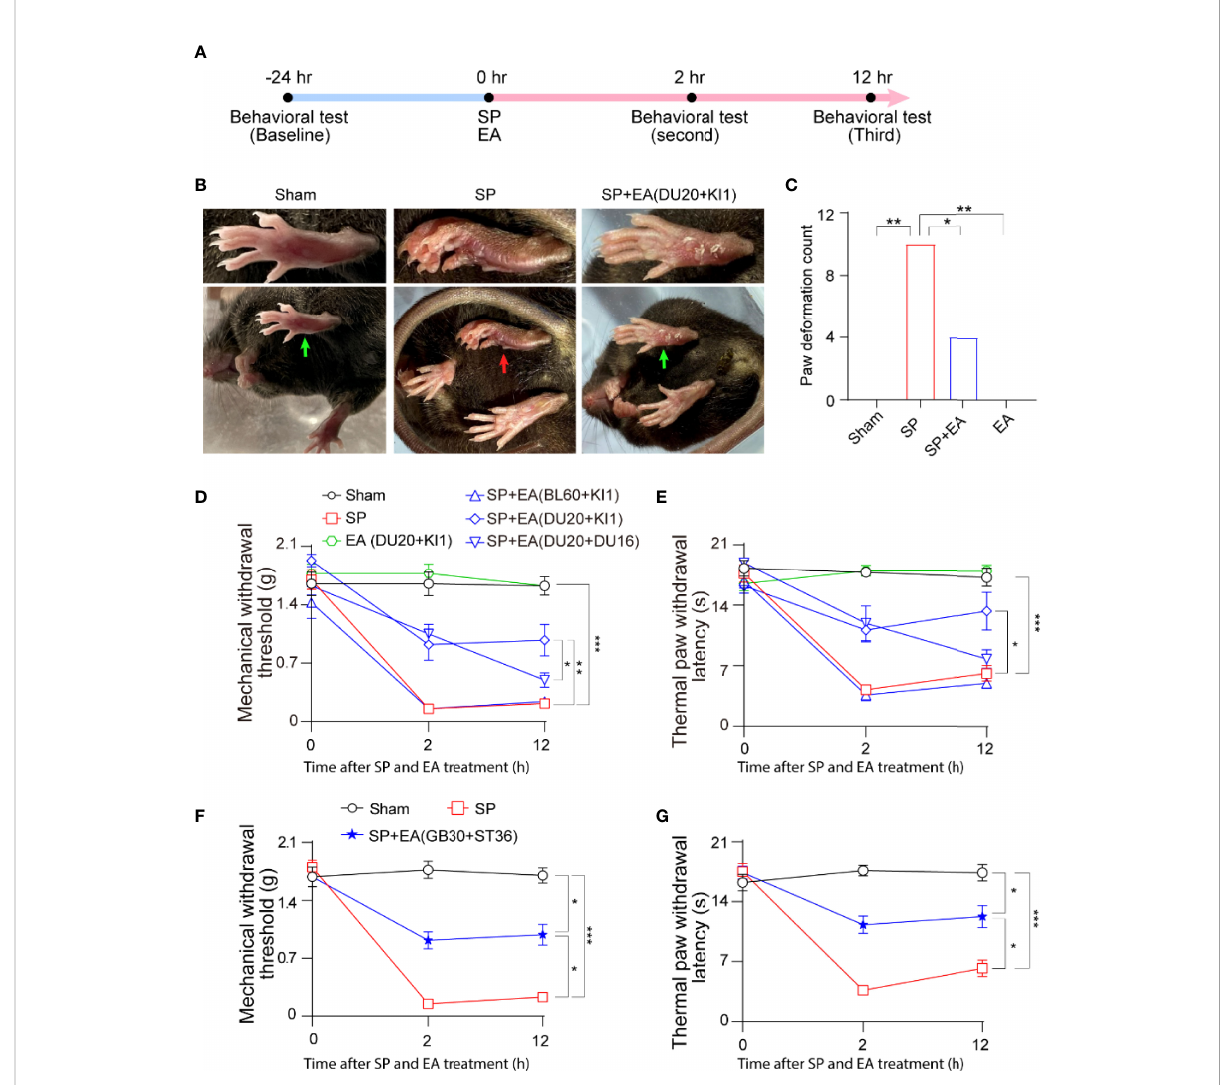
FIGURE 1 EA attenuates surgical pain (SP) in mice. (A) Diagram of procedures and behavioral tests. (B) Representative photos of paw deformation induced by SP in the foot. The red arrow indicates paw deformation in surgery mice; green arrows indicate normal paw in sham and SP plus EA mice. (C) Paw deformation counted at 12 h after the surgical incision. Effects of EA on paw deformation counted in mice that underwent foot incision. p -values indicate the difference in the counts between SP vs. sham; SP vs. SP plus EA (DU20+KI1); SP vs. EA ( n = 12, Fisher ’ s exact test). (D) Effects of EA on mechanical withdrawal threshold. p -values indicate the difference in the threshold between SP vs. sham; SP vs. SP plus EA (DU20+KI1); SP plus EA (DU20+DU16) vs. SP plus EA (DU20+KI1) ( n = 12, two-way ANOVA followed by Bonferroni post-hoc analyses). (E) Effects of EA on thermal paw withdrawal latency. p -values indicate the difference in the latency between SP vs. sham; SP vs. SP plus EA (DU20+KI1) ( n = 12, two-way ANOVA followed by Bonferroni post-hoc analyses). (F) Effects of EA on mechanical withdrawal threshold. p -values indicate the difference in the threshold between SP vs. sham; SP vs. SP plus EA (GB30+ST36); SP plus EA (GB30+ST36) vs. sham ( n = 12, two-way ANOVA followed by Bonferroni post-hoc analyses). (G) Effects of EA on thermal paw withdrawal latency. p -values indicate the difference in the latency between SP vs. sham; SP vs. EA (GB30 +ST36); EA (GB30+ST36) vs. sham ( n = 12, two-way ANOVA followed by Bonferroni post-hoc analyses). Data are represented as mean ± SEM. * p < 0.05, ** p < 0.01, *** p < 0.001. SP, surgical pain; EA, electroacupuncture; SEM, standard error of mean; BL60, DU20, DU16, KI1, GB30, and ST36: